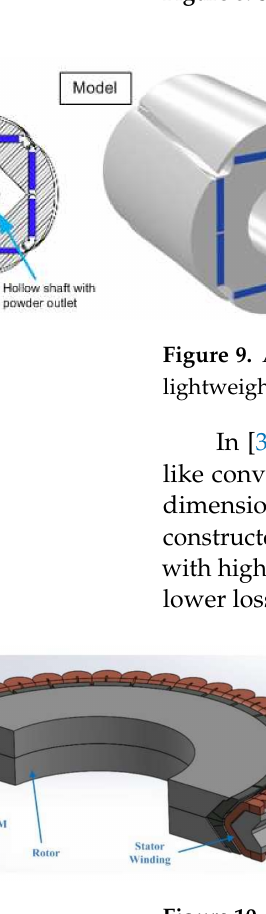
Figure 10. Additively manufactured 3D-flux PM brushless machine with spray-formed soft magnetic material core